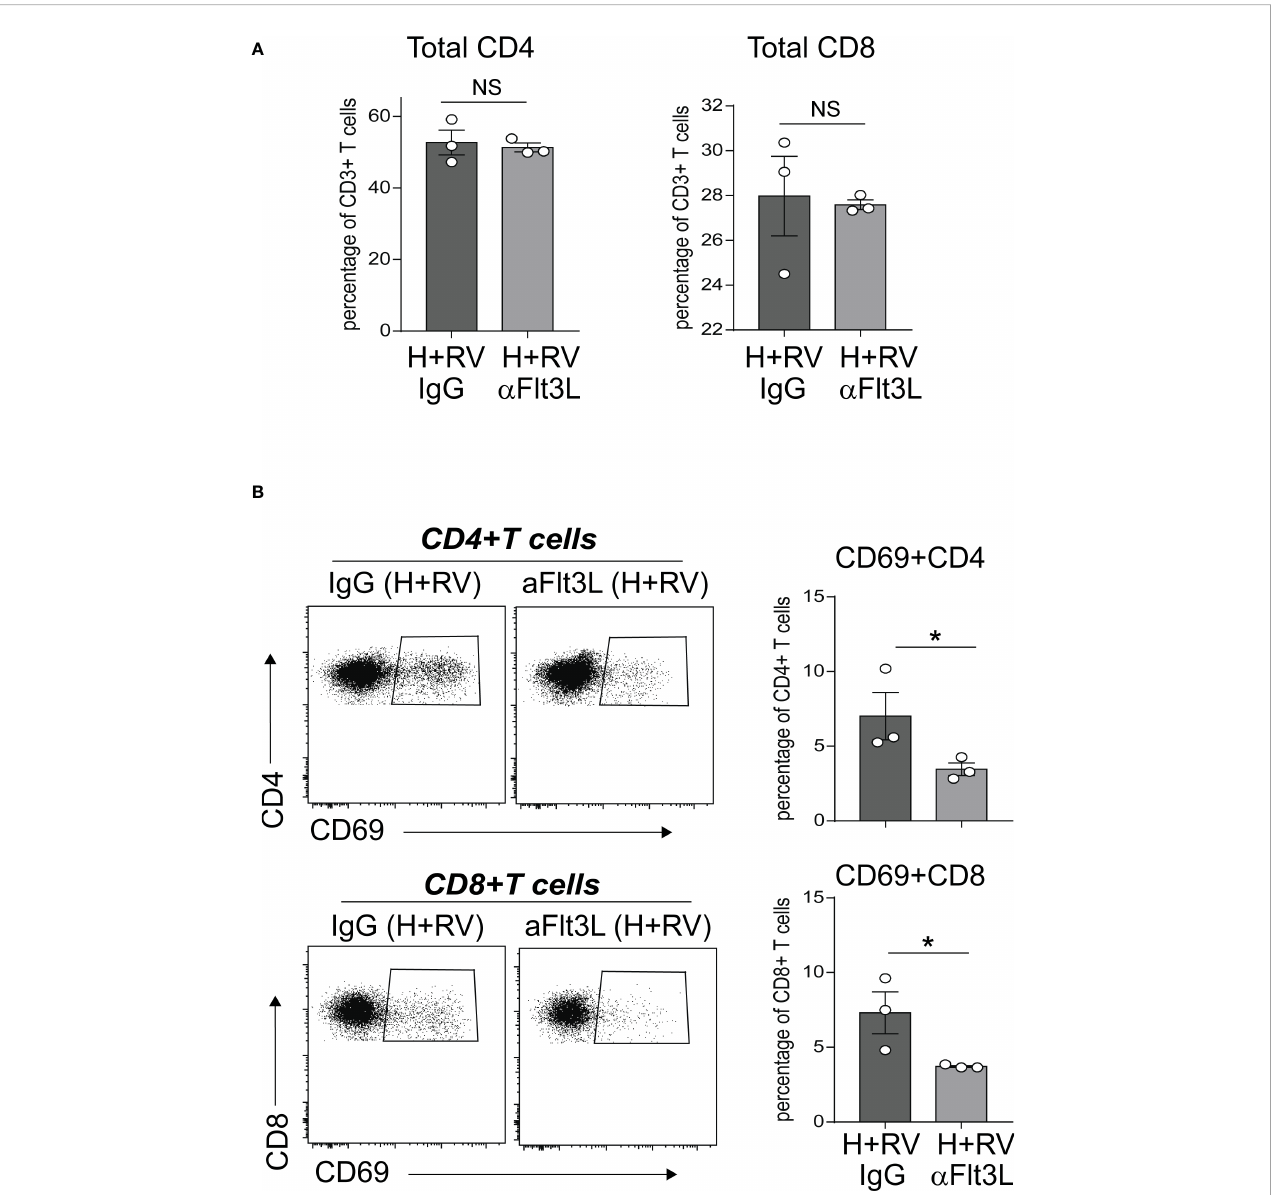
FIGURE 6 In vivo blockade of Flt3L with anti-Flt3L attenuates hyperoxia-induced in fl ammatory response to RV. Two-day-old mice were exposed to hyperoxia and treated with anti-Flt3L or IgG once daily. After 11 days of hyperoxia exposure and antiFlt3L treatment, mice were inoculated with RV intranasally. Five days later, total and activated CD69+ T cells in lungs were analyzed by fl ow cytometry. Total CD4 and CD8 T cells (A) , as well as CD69+CD4+ and CD69 +CD8+ T cells (B) were quanti fi ed in lung. Each dot is representative of two immature mouse lungs. * P <0.05 (one-way ANOVA), NS, non-signi fi